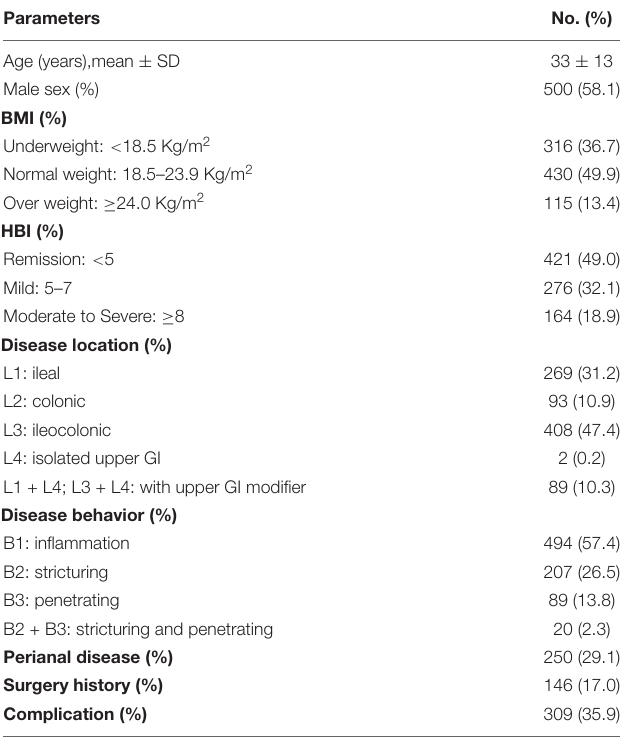
TABLE 2 | Demographic and phenotypic characteristics of patients with CD.